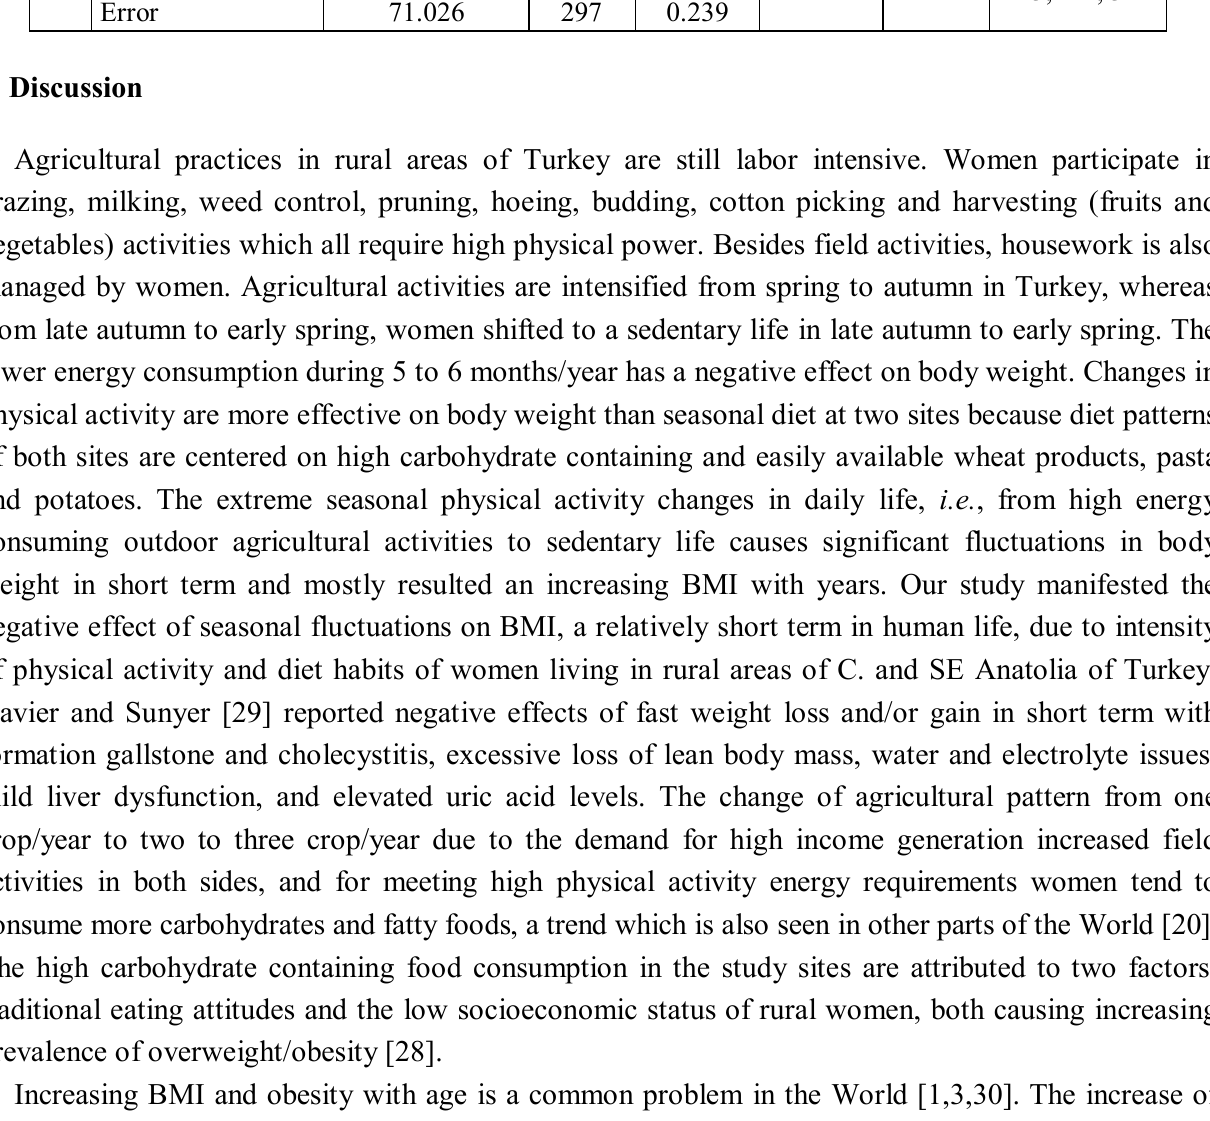
Table 5. ANOVA results for 2009 and 2010 for BMI values among groups and between study sites. Type III Sum Mean Significant Source df F P of squares squares differences Between subjects 4,532.703 99 45.785 2009 1-2, 1-3, 1-4, 376.698 0.000 Measure 126.854 3 42.285 2-3, 2-4, 3-4 Error 33.339 297 0.112 Between subjects 4,524.508 99 45.702 2010 1-2, 1-3, 1-4, Measure 113.587 3 37.862 158.324 0.000 2-3, 2-4, 3-4 Error 71.026 297